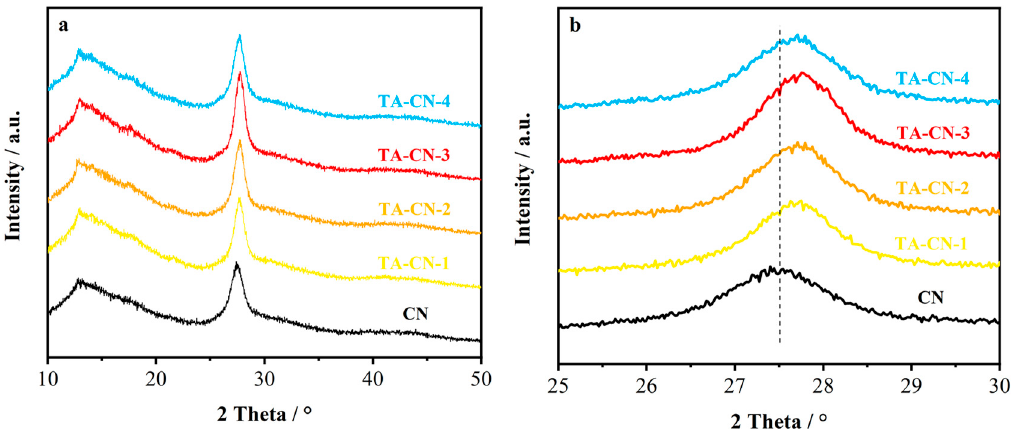
Figure 2. ( a ) XRD patterns of CN and TA-CN-x, ( b ) enlarge view between 25 ° and 30 ° .